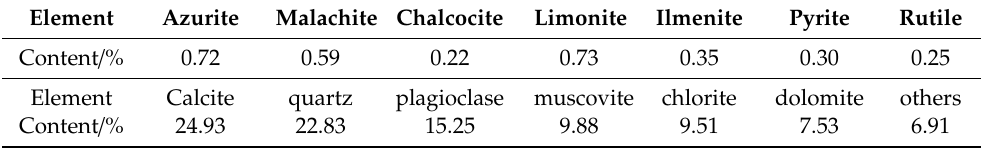
Figure 1. X-ray diffraction (XRD) spectra of pure ( a ) Azurite and ( b ) Malachite for tests. Figure 1. X-ray di ff raction (XRD) spectra of pure ( a ) Azurite and ( b ) Malachite for tests. Table 1. Chemical analysis results of practical samples. Table 1. Chemical analysis results of practical samples.